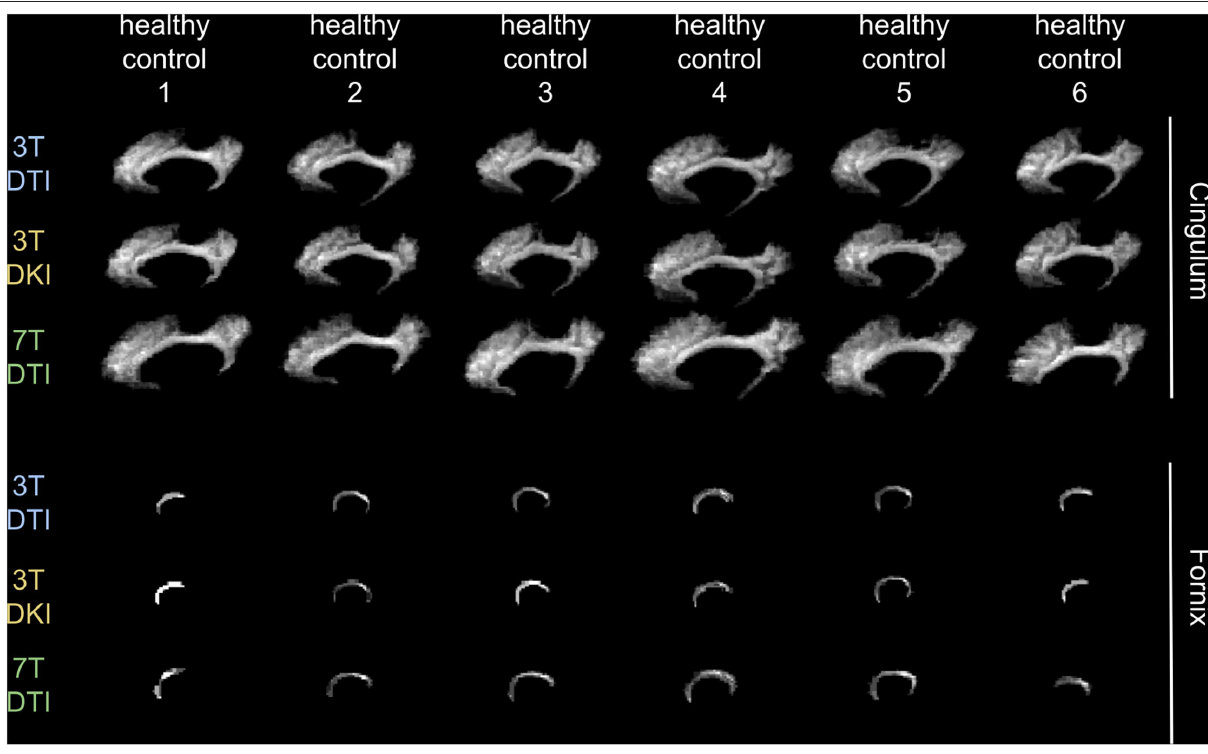
Frontiers in Neurology |